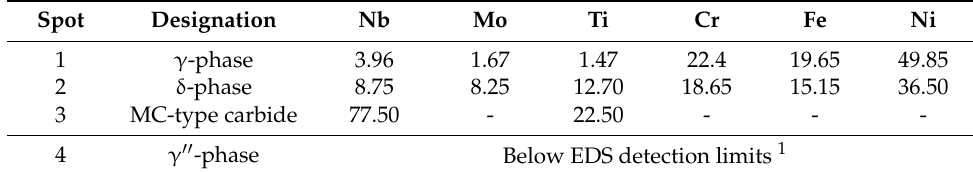
Table 3. EDS spot analysis of the homogenized IN718 specimen in at